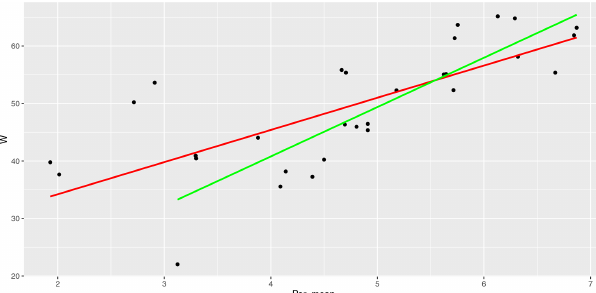
Figure A8. The correlation of the WI with the mean temperature in Paris (ERA5; 1981–2010), a linear regression (red line) over all data points, and a linear regression (green line) excluding outstanding and/or extraordinary years (1985, 1986, 1987, and